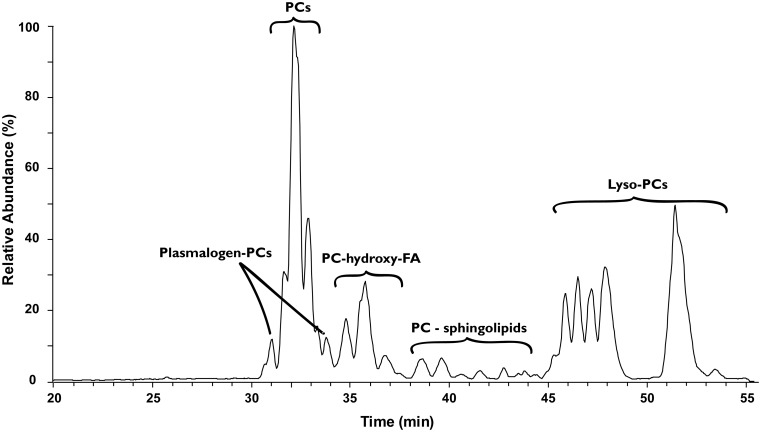
LC–MS chromatogram showing identified intact polar lipids in brown trout (Salmo trutta) gill tissue.Base peak LC–MS chromatogram (Gaussian smoothed) of MS1 of intact polar lipids (IPLs) in brown trout (Salmo trutta) gill tissue showing the prevalence of the nitrogen-containing IPL phosphatidylcholine. PC = phosphatidylcholine.